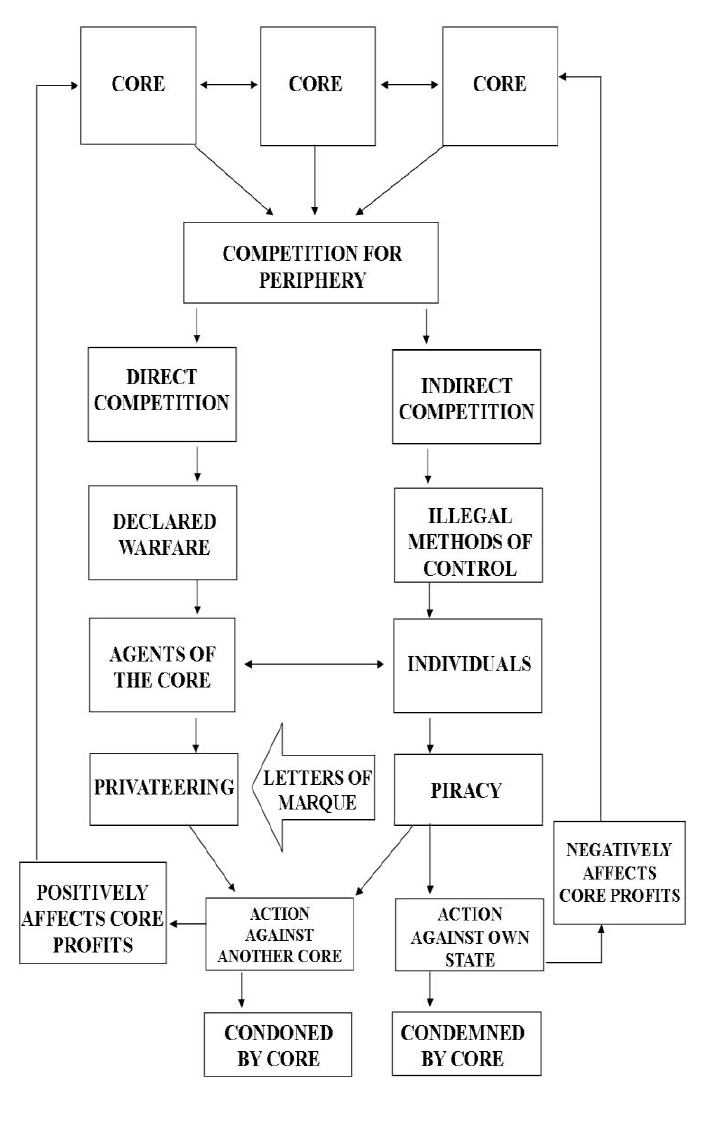
Figure 2. The status of piracy and privateering in a contested